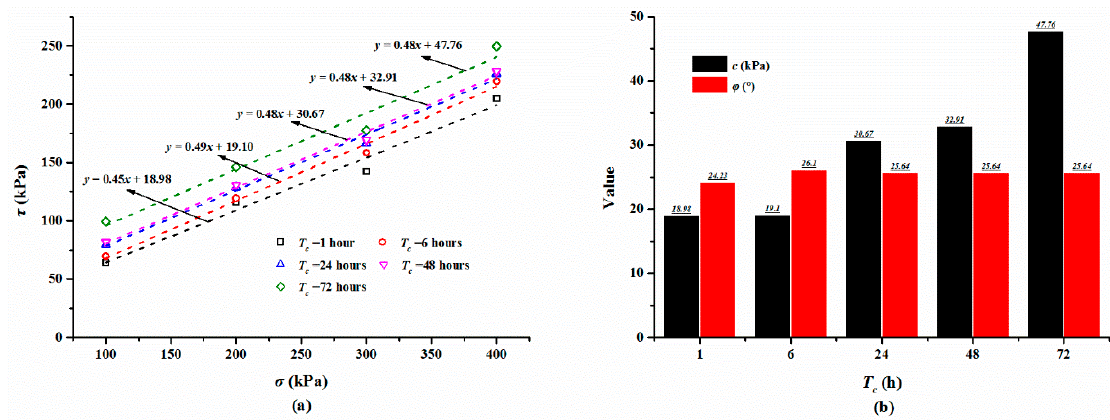
Figure 7. ( a ) The relationship between shear strength τ and normal stress σ ; ( b ) The relationship between the shear strength parameters ( c and φ ) and curing time T c .